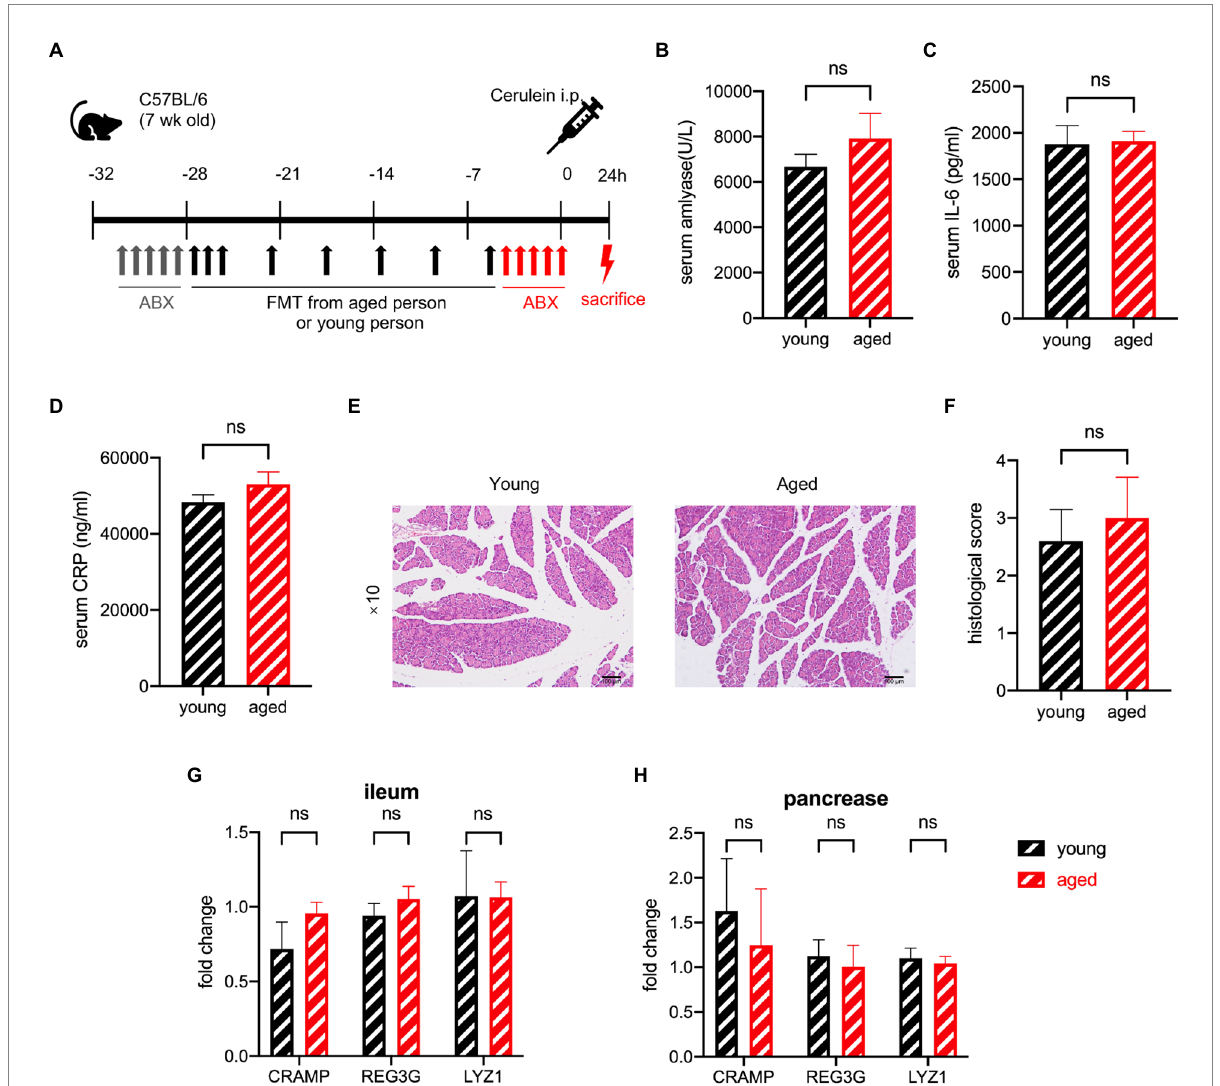
FIGURE 7 (A) Experimental design for gut depletion before SAP. (B) Serum amylase, serum IL-6 (C) , and serum CRP (D) levels are significantly increased in the old group compared to the young group. (E) Typical pathological image of two groups. (F) Histological scoring of pancreatic damage ( n = 5 per group). Expression of AMP genes in the pancreas (G) and ileum (H) of the young group versus the old group ( n = 7 per group). * p < 0.05, ** p < 0.01, *** p < 0.001, **** p < 0.0001, ns, no significant